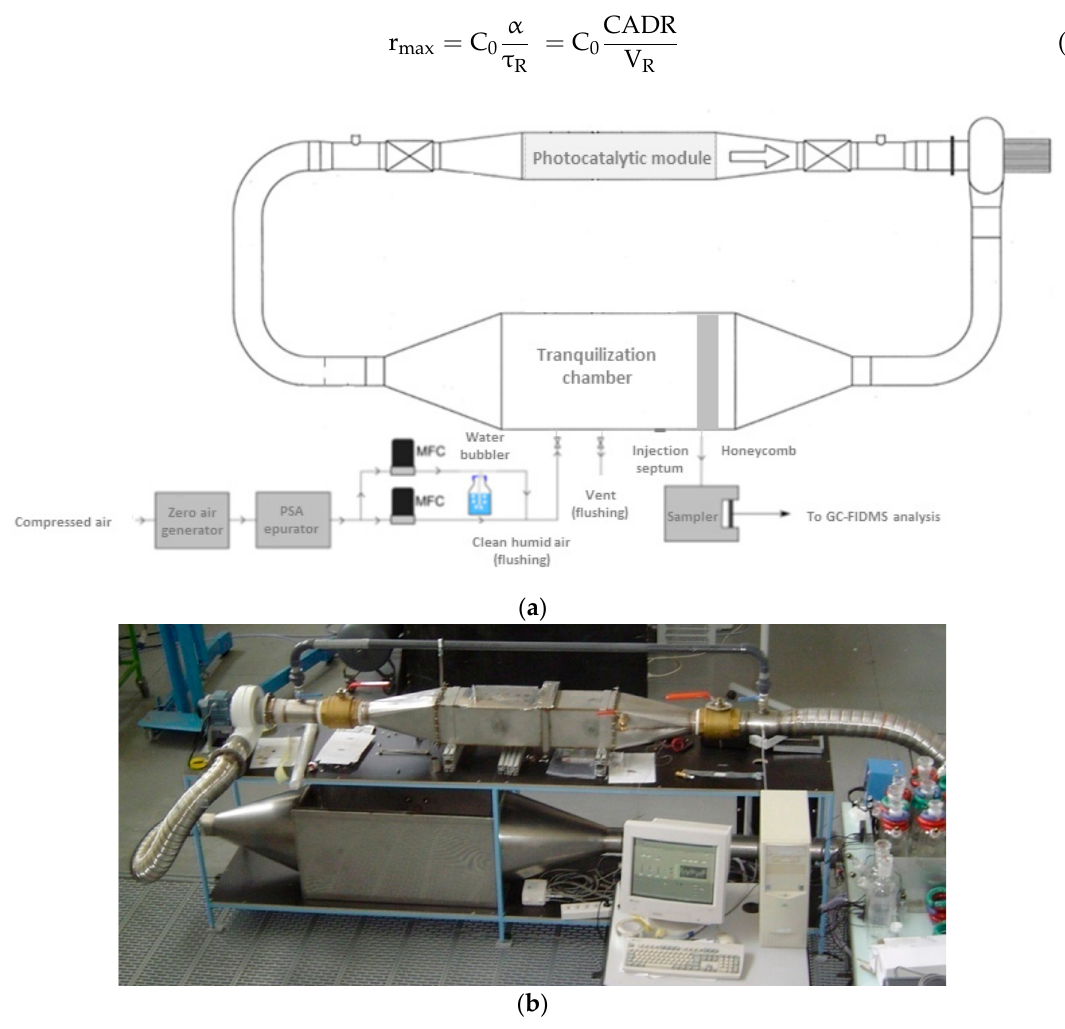
Figure 1. Experimental closed-loop reactor operating in recirculation mode. ( a ) Schematic representation; and ( b ) photograph of the whole system.